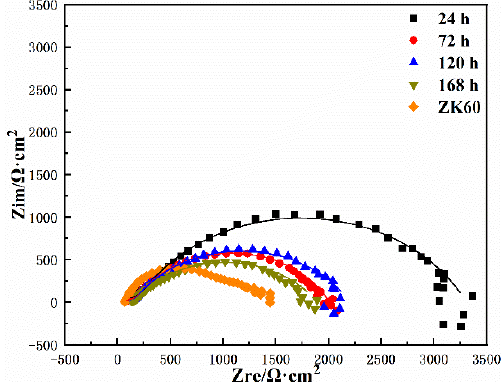
Figure 10. EIS spectra of ZK60 and 12 h samples at different immersion times: Nyquist plots.